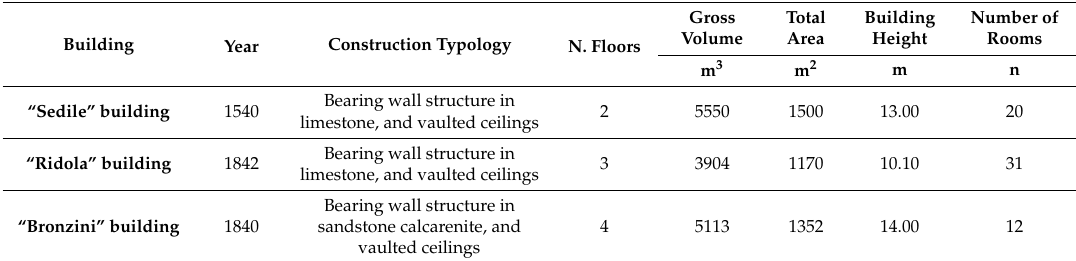
Table 1. Geometric characteristic of the case study.